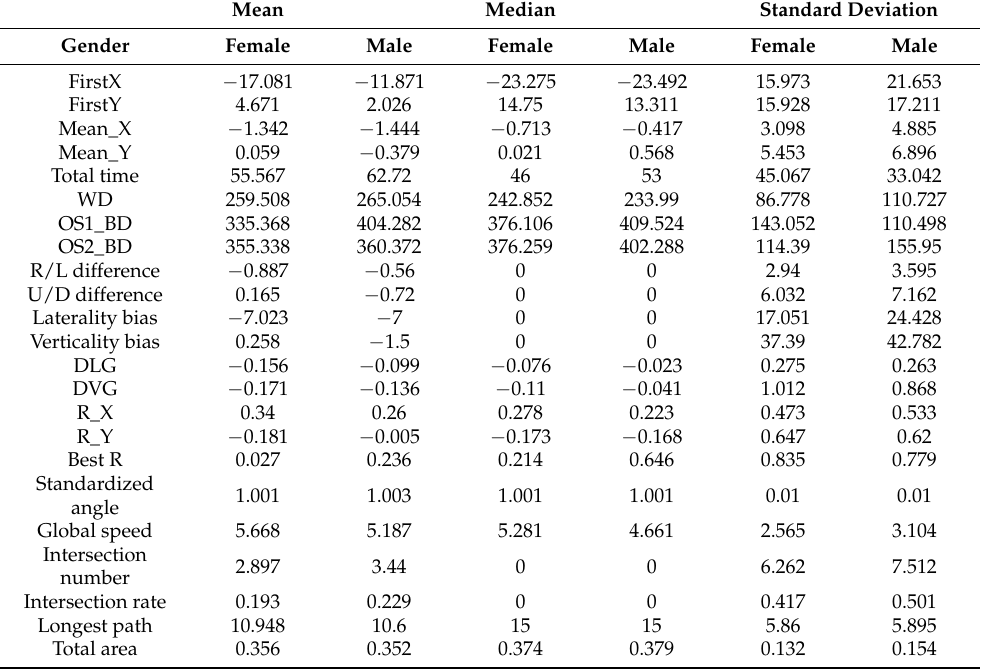
Table 3. Descriptive statistics for the list of indexes divided for gender. OS1_BD = optima sequence number 1_between distance; OS2_BD = optima sequence number 2_between distance; WD = within distance; DLG = distance lateral gradient; DVG = distance vertical gradient.